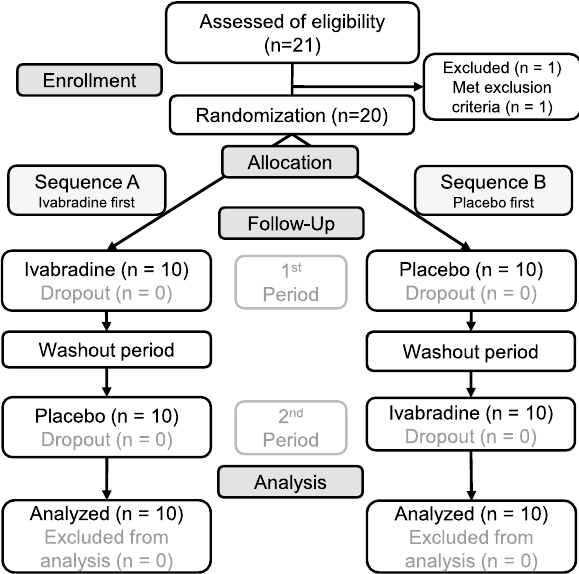
Figure 1. CONSORT diagram illustrating subject flow during the study.